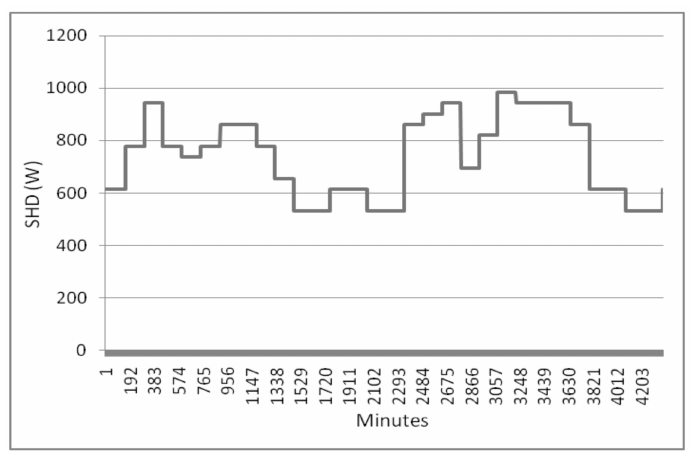
Figure 7. Example of Space Heating Demand (SHD) profile (December).